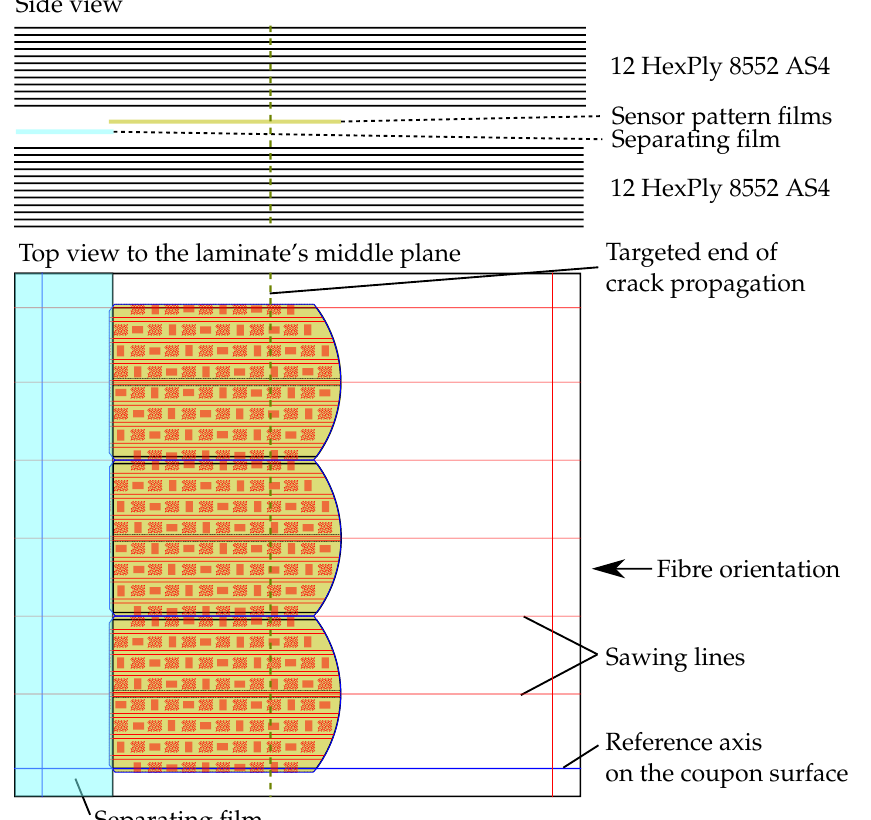
Figure 5. Stacking sequence, cutting plan and film placement in the DCB coupons. A coupon containing a sensor pattern in 0° direction is shown. For each orientation of the sensor pattern a laminate as displayed was manufactured. Coupons were manufactured with the following integrated films: PEI @ 0°, 45° and 90°, PEI without sensor pattern, PI @ 0° and without sensor pattern. As a reference, the experimental results from an earlier investigation [25] made from the same material (HexPly 8552 AS4) were used. The green dashed line indicates the final crack length pursued in the DCB